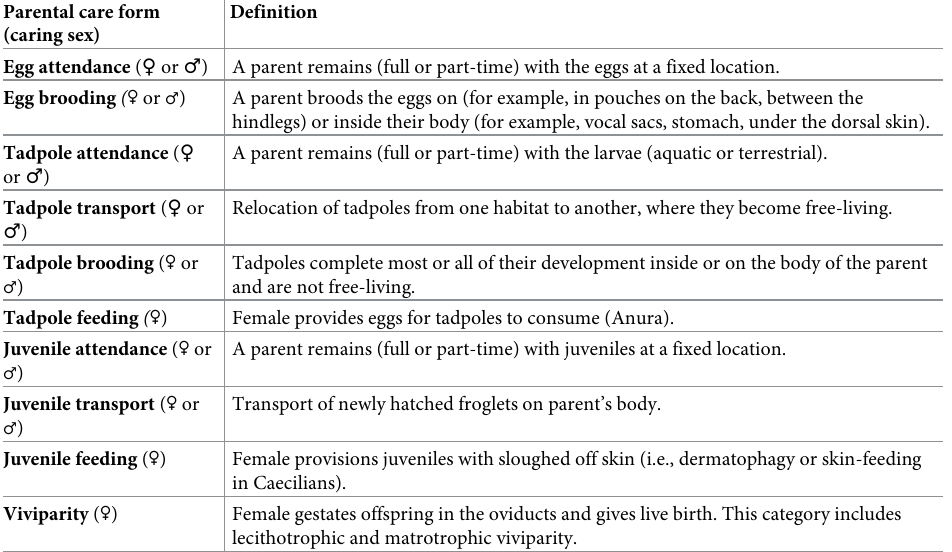
Table 1. Description of amphibian parental care. Brief definition of parental care forms from Furness and Capellini [69], where details of the data collection protocols can be found. Sample sizes for the variables as used in this study can be found in S2 Table. All care forms with the exception of tadpole feeding and viviparity can be carried out by either (or both) sexes in a